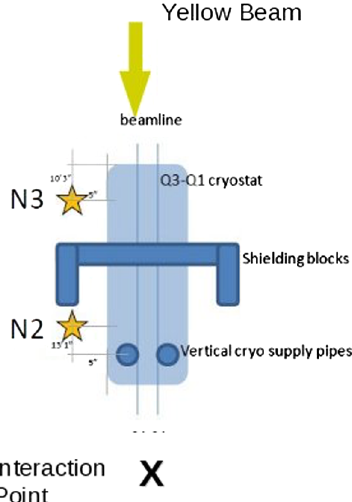
FIG. 22. Location of two experimental background monitors (scintillators), N2 and N3, in the PHENIX interaction region.